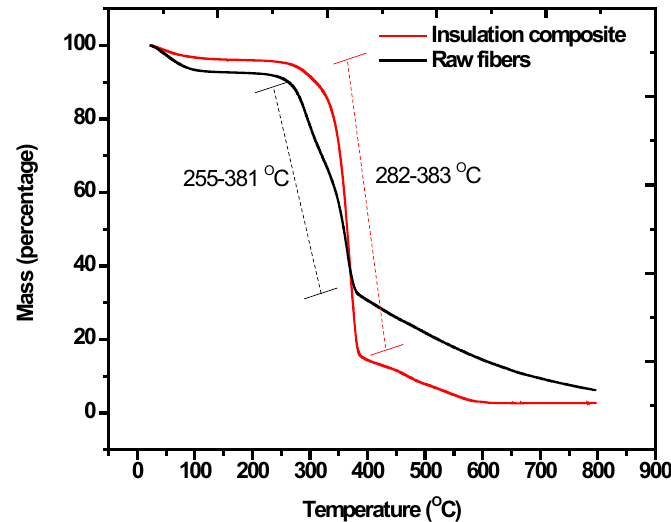
Figure 11. TGA curves of raw fibers and the insulation composite.